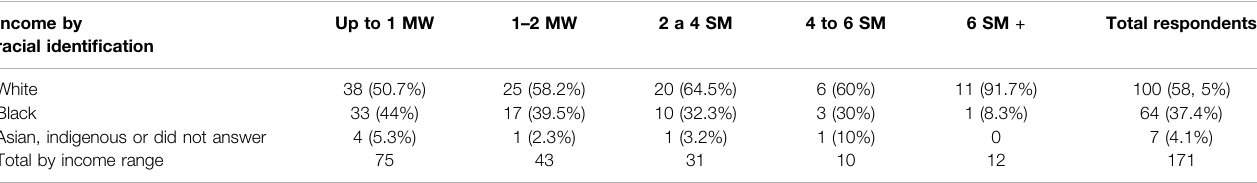
TABLE 3 | Monthly income by racial identi fi cation - in the context of the pandemic. Income by racial identi fi